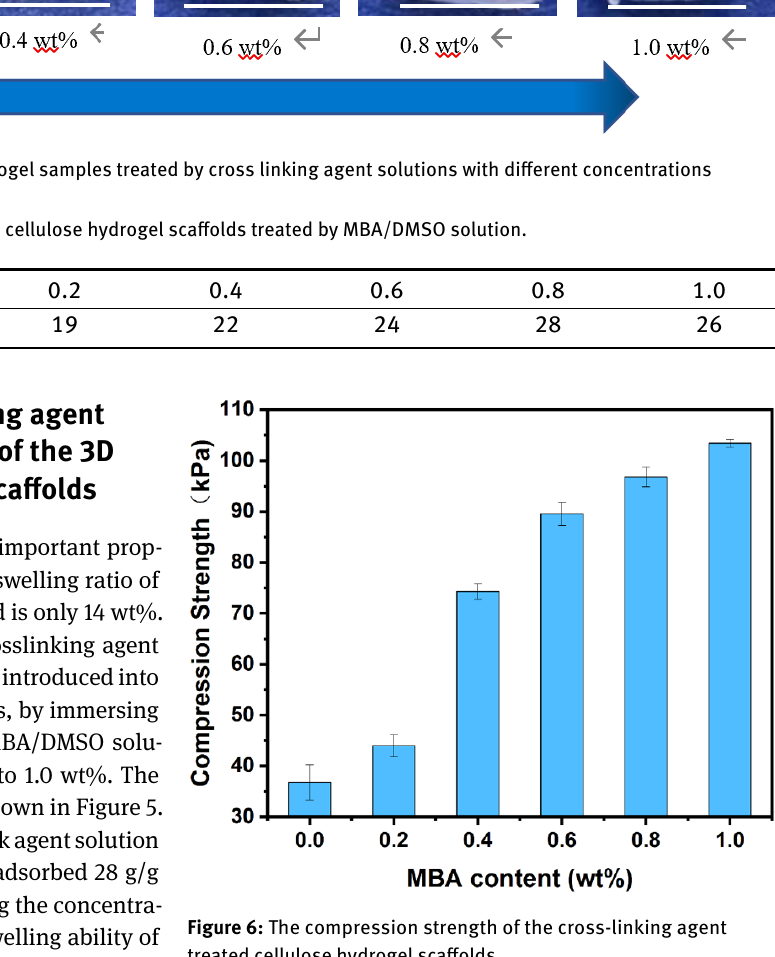
Figure 6: The compression strength of the cross-linking agent treated cellulose hydrogel